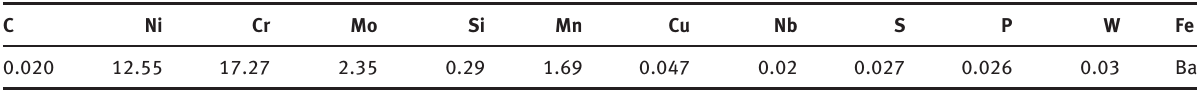
Table 1: Chemical composition (wt%) of substrate material (AISI 316LN).